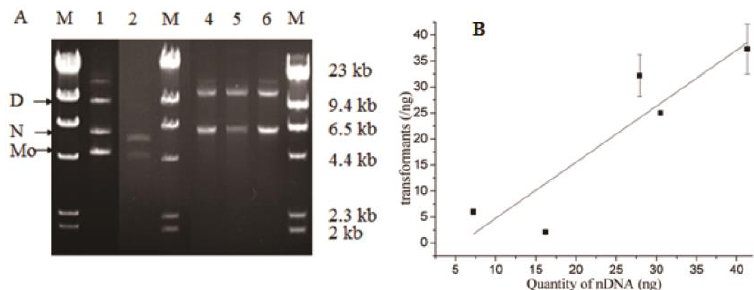
Figure 6. Analysis of nicked circular plasmid (nc-plasmid) DNAs ( A ) and correlation with transformants (B). (A) Gel-electrophoresis separated the HR products of pET20b- AdD (L2), pET21a- AdD (L4), and pET22b- AdD DNAs (L6) into component as monomer (Mo), nicked circular (N), and dimer DNAs (D). Similar components separated for the ligation products of pET20b- AdD (L1) or pET22b- AdD (L5). Different components were quantified by Gel-Pro analyzer software. ( B ) Correlation analyzed for quantity of nc-plasmid DNAs with transformant efficiency by Origin software. An equation was: Y = -6.03 + 1.08 × X (error bars represent standard deviation, Adj. R-Square 0.74).